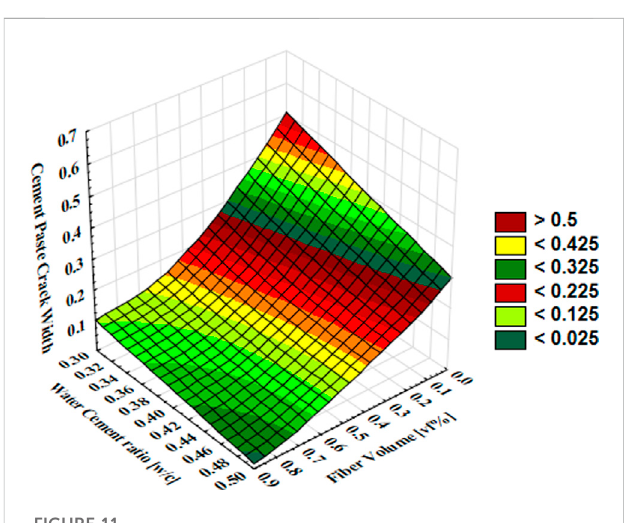
FIGURE 9 Cement-paste cracking age (h) against fi bre V f (%) and w/c ratio.